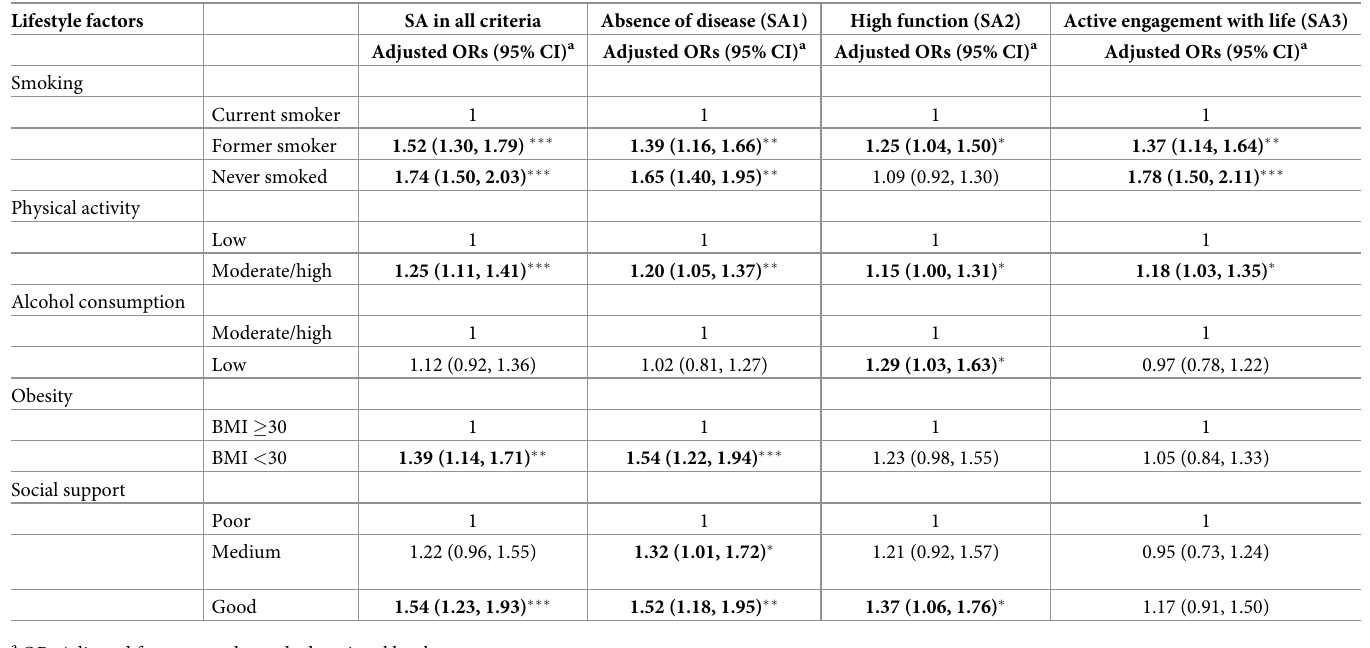
Table 3. Likelihood of SA as a unified and split concept (multivariate regression analyses) as adjusted (n = 3769) odds ratios